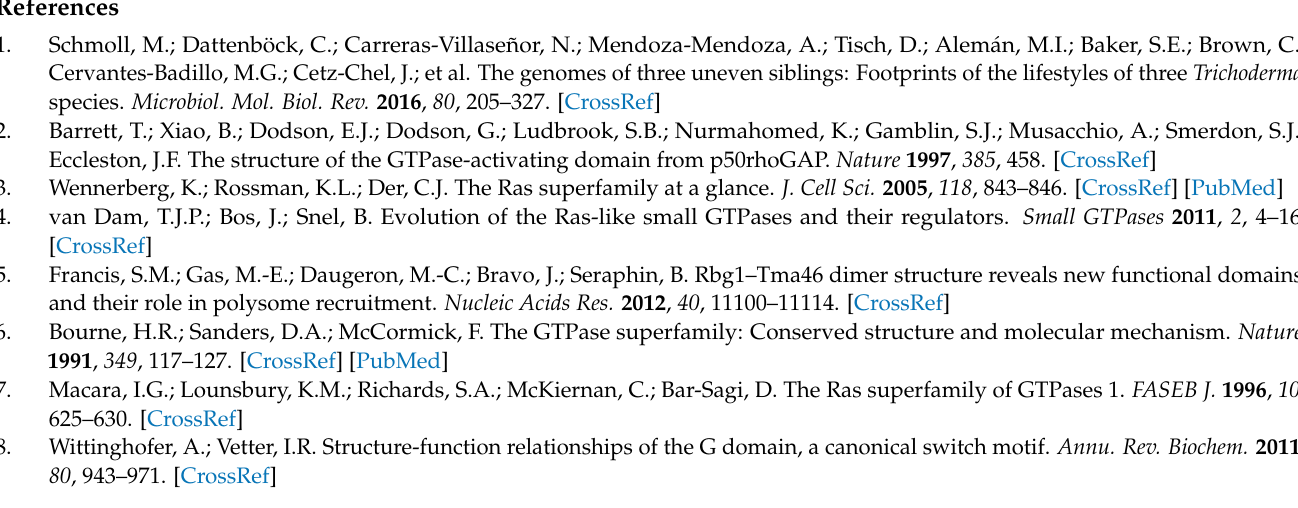
in fungi. Figure S2: The Arf proteins have conserved the G residue at the second position of the N-terminal. Figure S3: Phylogenetic relationships among the members of the Arf family in fungi, Figure S4: The GTPase II domain of the Miro proteins in fungi is less